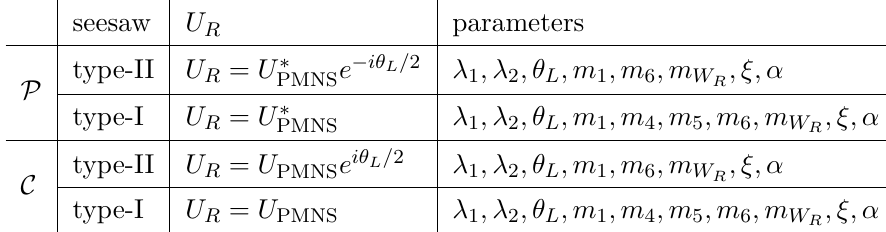
Table 4. Independent parameters for the cases we